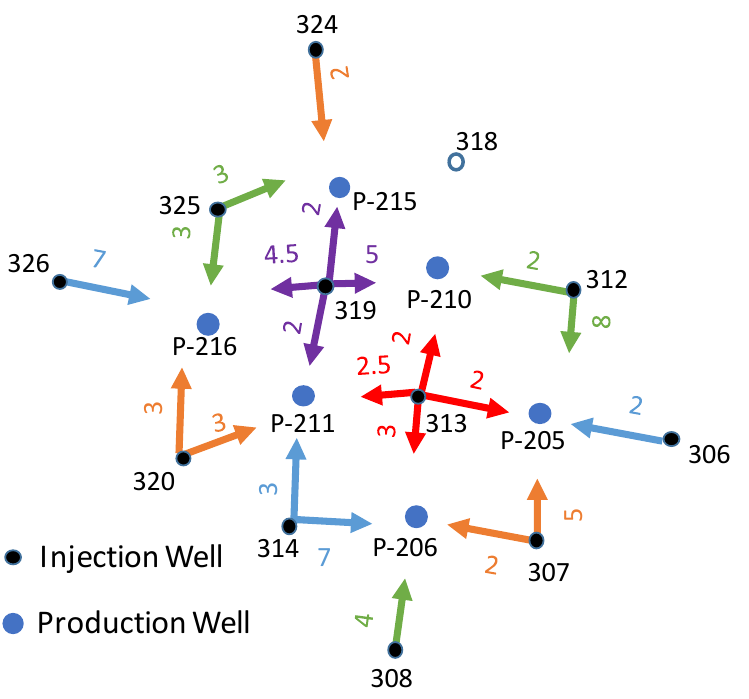
Figure A3. Approximate first-arrival times in days since the start of tracer injection for each of the injector–producer combinations (numbers next to arrows). Well numbers are shown next to dots representing wells. Lengths of arrows have no significance.